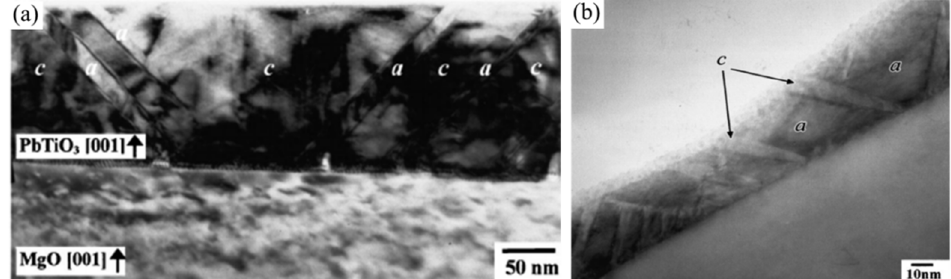
Figure 9. Cross-sectional TEM images of PbTiO 3 films deposited on ( a ) MgO (001) substrate and ( b ) KTaO 3 (001) substrate. Domain structures are: ( a ) mainly composed of c-domains and ( b ) a-domains. Reprinted with permission from [108] 2001 AIP Publishing.